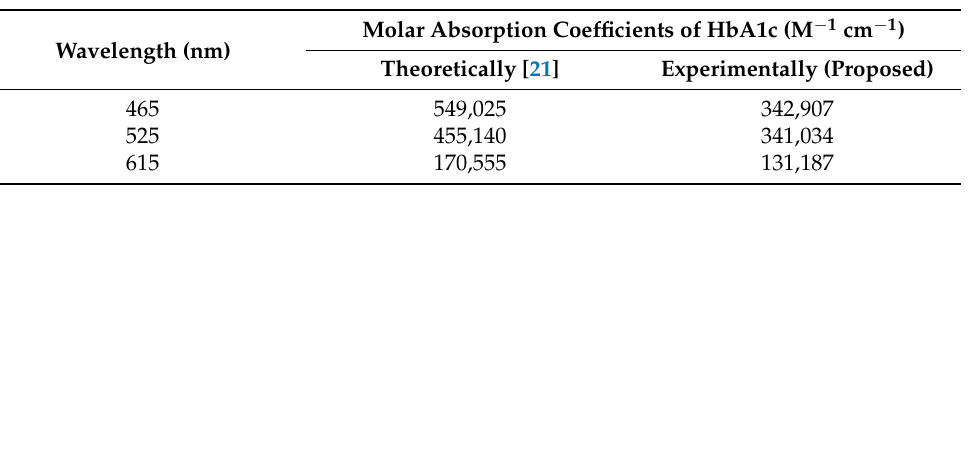
Table 2. Molar absorption coefficients of HbA1c obtained theoretically and experimentally at level